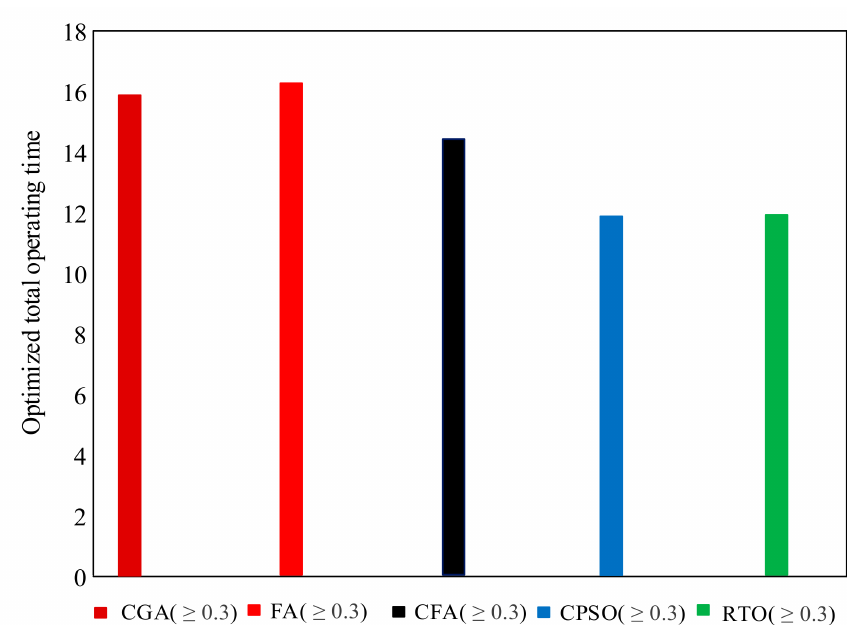
Figure 10. Optimized total operating time with the literature for Case